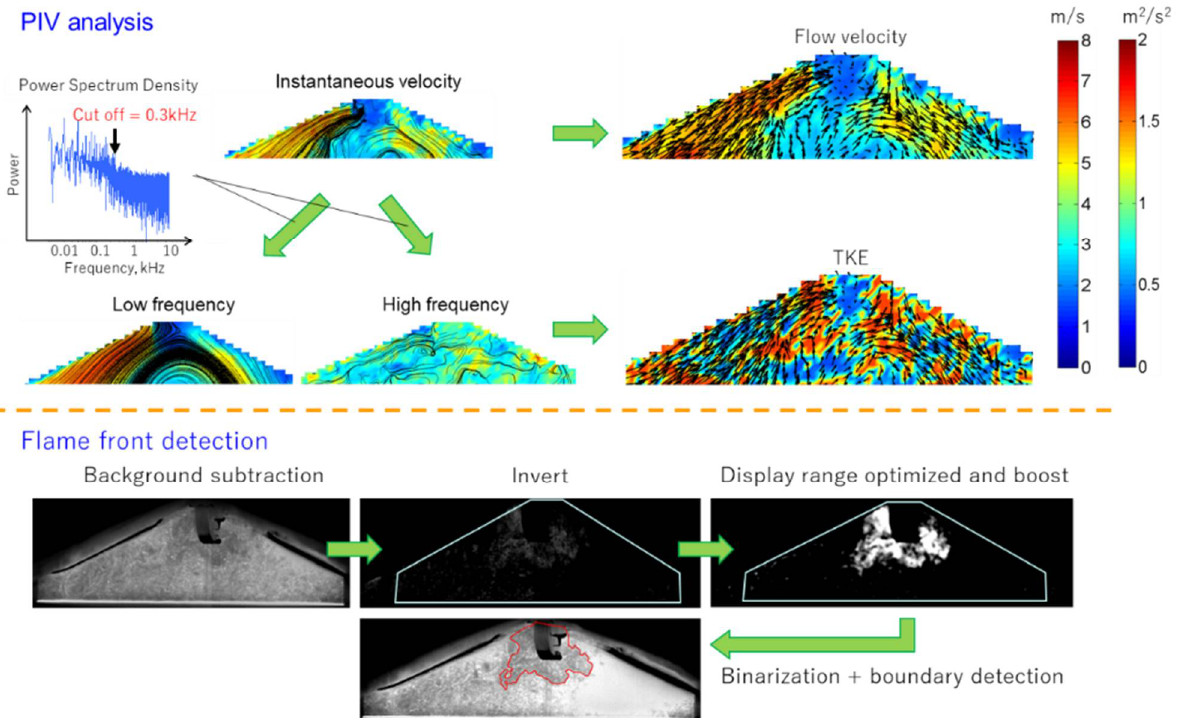
Figure 6. Image processing of the flow and turbulence detection with flame front detection.